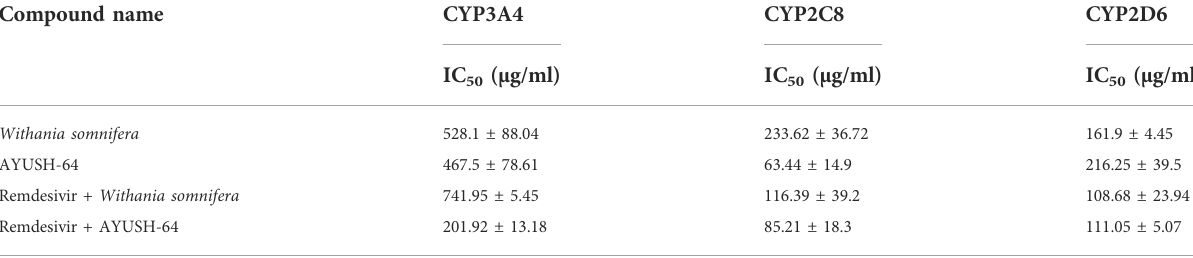
TABLE 1 IC 50 values of Withania somnifera and AYUSH-64 extracts for CYP3A4, 2C8, and 2D6 isoenzymes.